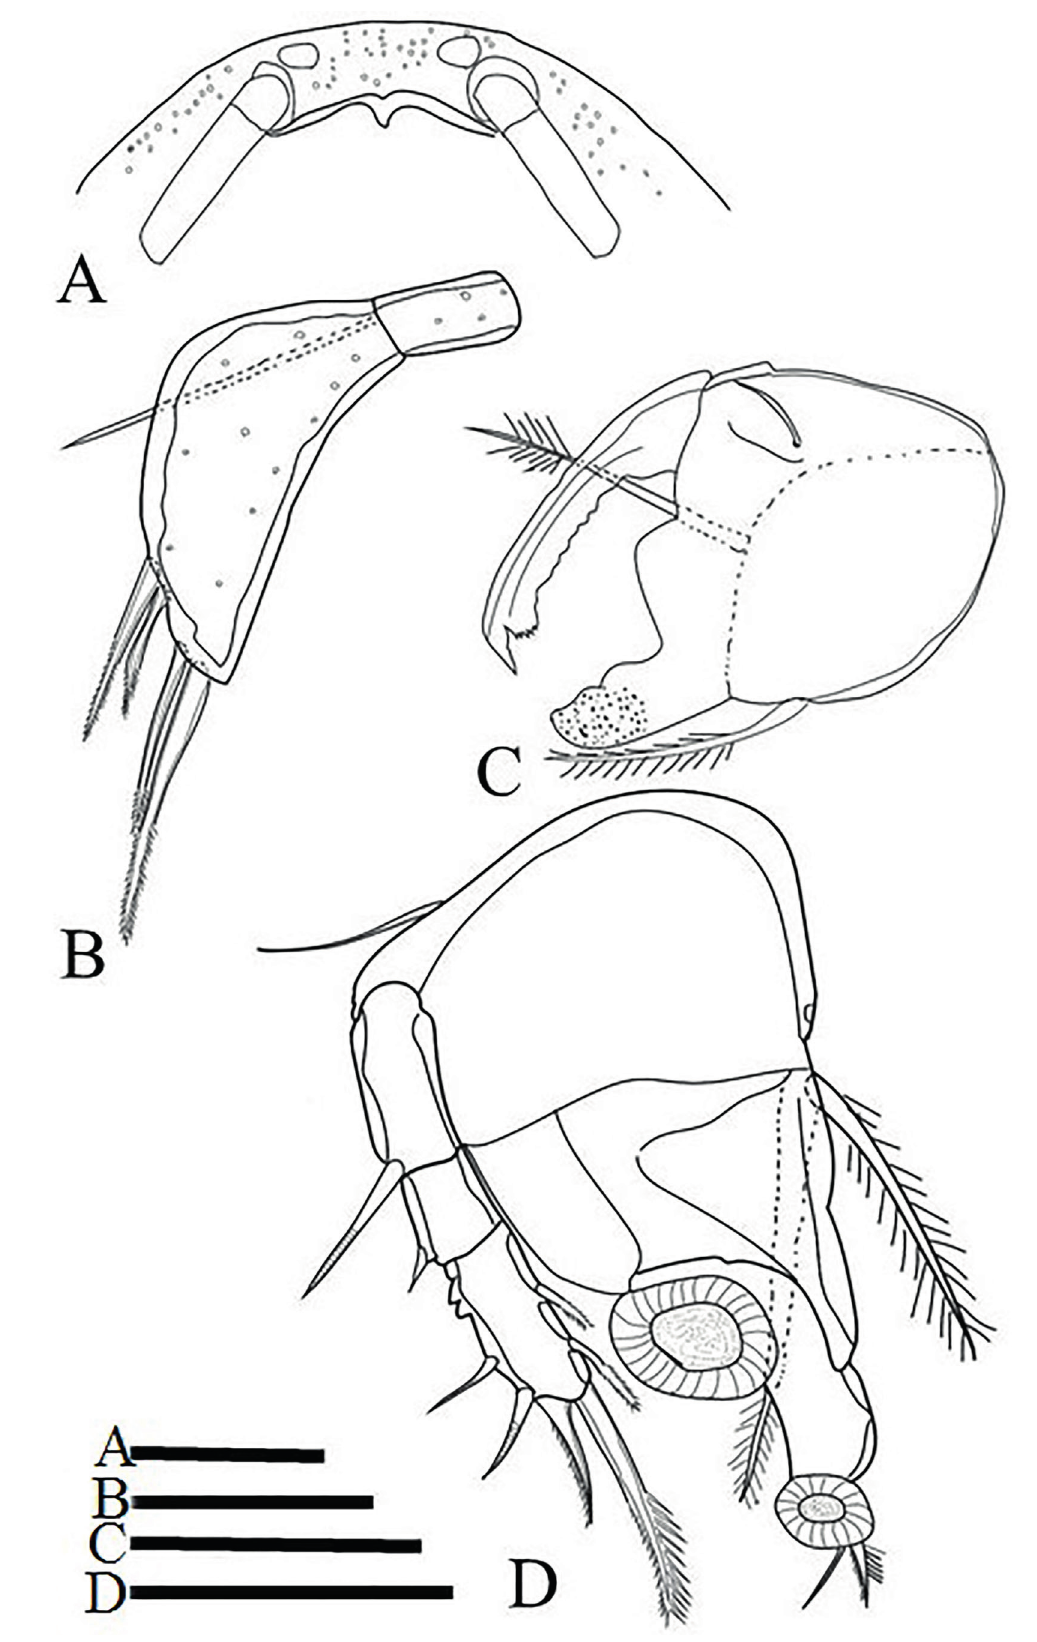
Figure 6. Clausidium persiaensis sp. nov. A, rostrum (female); B, P5 (female); C, maxilliped (male); D, P1 (male). Scale bars: A–C, 25 μm; D, 100